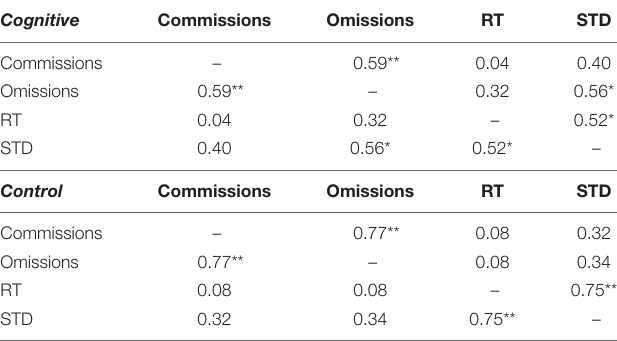
TABLE 2 | Pearson correlations between CPT variables.